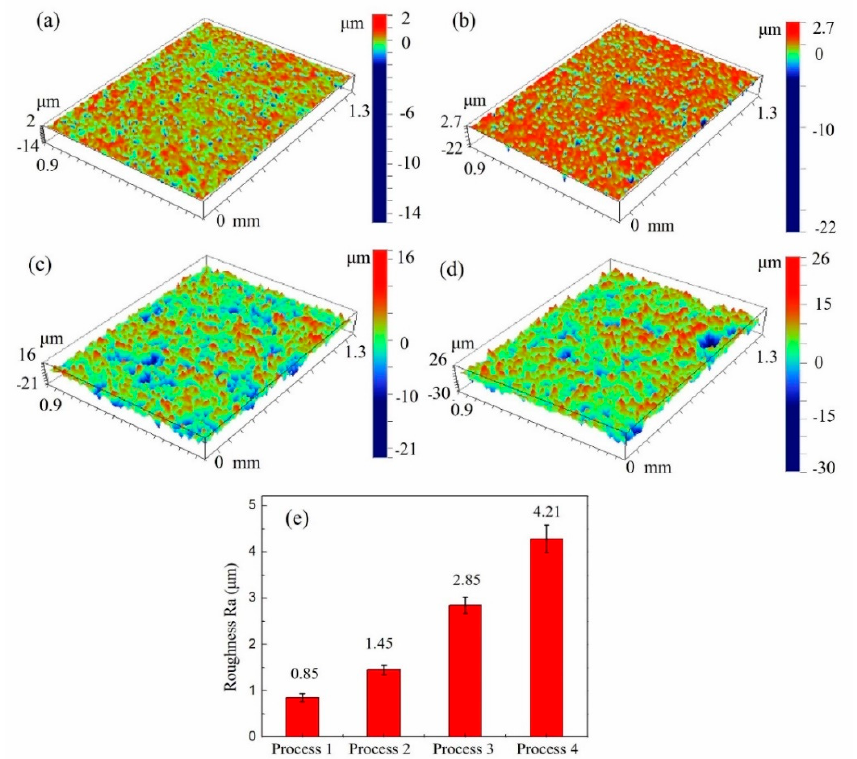
Figure 8. Profilometry of rough surfaces created by combined methods: ( a ) process 1, ( b ) process 2, ( c ) process 3, ( d ) process 4, and ( e ) values of R a .